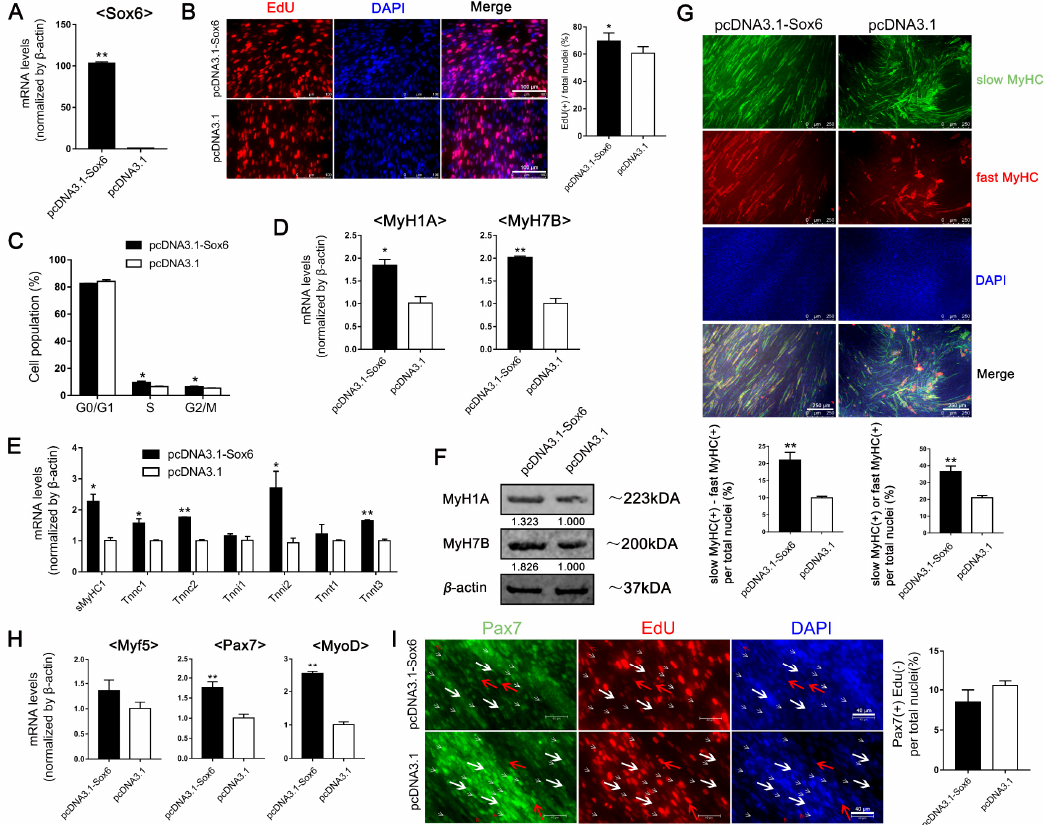
Figure 3. Sox6 in LM-derived satellite cells promotes cell proliferation, fast-type and slow-type fibers’ formation. ( A ) The relative expression levels of Sox6 in Sox6 -overexpressing LM-MBs were quantified by qPCR (mean ± SEM; ** p < 0.01; n = 3; two-tailed Student’s t -test). ( B ) Proliferation of Sox6 -overexpressing LM-MBs were assessed by Edu (mean ± SEM; * p < 0.05; n = 3; two-tailed Stu- dent’s t-test). ( C ) Cell cycle analysis of Sox6 -overexpressing LM-MBs (mean ± SEM; * p < 0.05; n = 3; two-tailed Student’s t -test). ( D ) After inducing differentiation for 3 days, the relative expression levels of MyH1A and MyH7B in Sox6 -overexpressing LM-MTs were quantified by qPCR (mean ± SEM; * p < 0.05; ** p < 0.01; n = 3; two-tailed Student’s t -test). ( E ) After inducing differentiation for 3 days, the relative expression levels of fast- and slow-type fiber isoforms in Sox6 -overexpressing LM- MTs were quantified by qPCR (mean ± SEM; * p < 0.05; ** p < 0.01; n = 3; two-tailed Student’s t -test). ( F ) Western blot on lysates from Sox6 -overexpressing LM-MTs and control groups myotubes after inducing differentiation for 3 days. β -actin was used to normalize. ( G ) After inducing differentiation for 3 days, myotubes derived from Sox6 -overexpressing LM-MTs were stained against S58 (slow- type MyHC, green) and F59 (fast-type MyHC, red) and nuclei were counterstained with DAPI. The slow MyHC(+) nuclei or fast MyHC(+) nuclei were counted. The proportion of slow MyHC(+) cells − fast MyHC(+) cells among total nuclei and the proportion of cells in slow MyHC(+) myotubes or fast MyHC(+) myotubes among total nuclei are presented as mean ± SEM (** p < 0.01; n = 3; two- tailed Student’s t -test). ( H ) After inducing differentiation for 3 days, the relative expression levels of Myf5 , Pax7 and MyoD in Sox6 -overexpressing LM-MBs were quantified by qPCR (mean ± SEM; ** p < 0.01; n = 3; two-tailed Student’s t -test). ( I ) Sox6 -overexpressing LM-MBs were cultured in DM